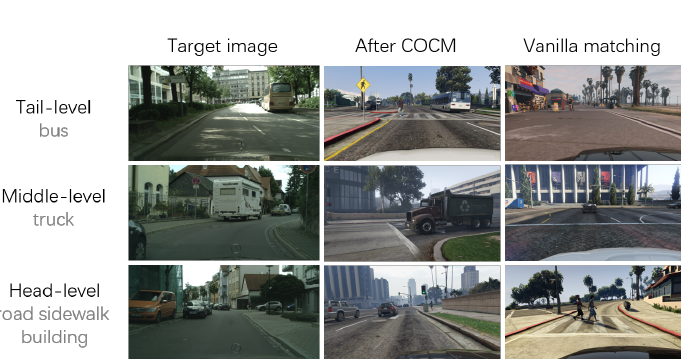
Figure 2. Examples of co-occurrence-based consistency matching on three